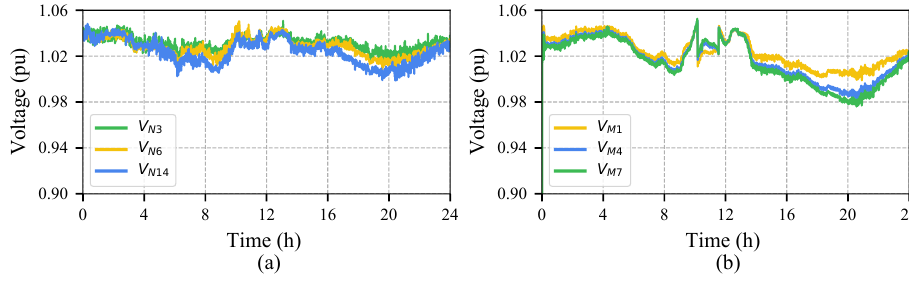
Figure 15. PSHIL-3. Impact on the MV and LV distribution networks. ( a ) 24-h evolution of the MV system voltage in buses N3, N6, and N14. ( b ) 24-h evolution of the LV system voltage in buses M1, M4, and